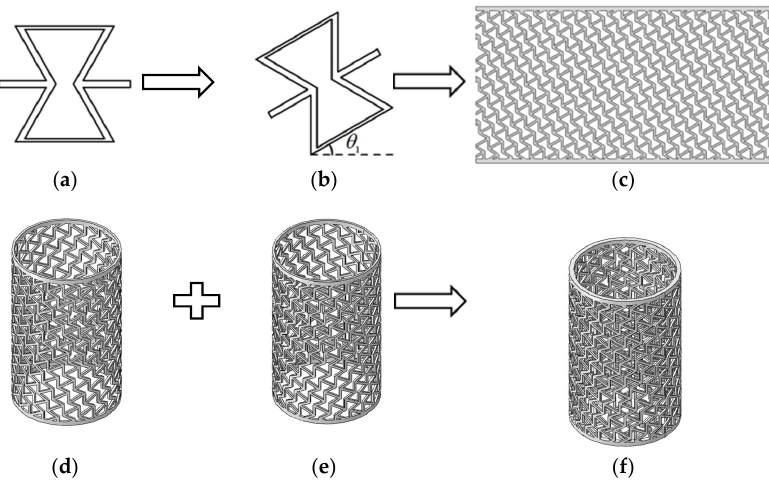
Figure 2. The process of constructing [ θ 1 / −θ 1 ] composite RHCS: ( a ) 0° re-entrant honeycomb cell; ( b ) θ 1 re-entrant honeycomb cell; ( c ) θ 1 re-entrant honeycomb layer; ( d ) θ 1 RHCS; ( e ) −θ 1 RHCS; ( f ) [ θ 1 / −θ 1 ] composite RHCS.